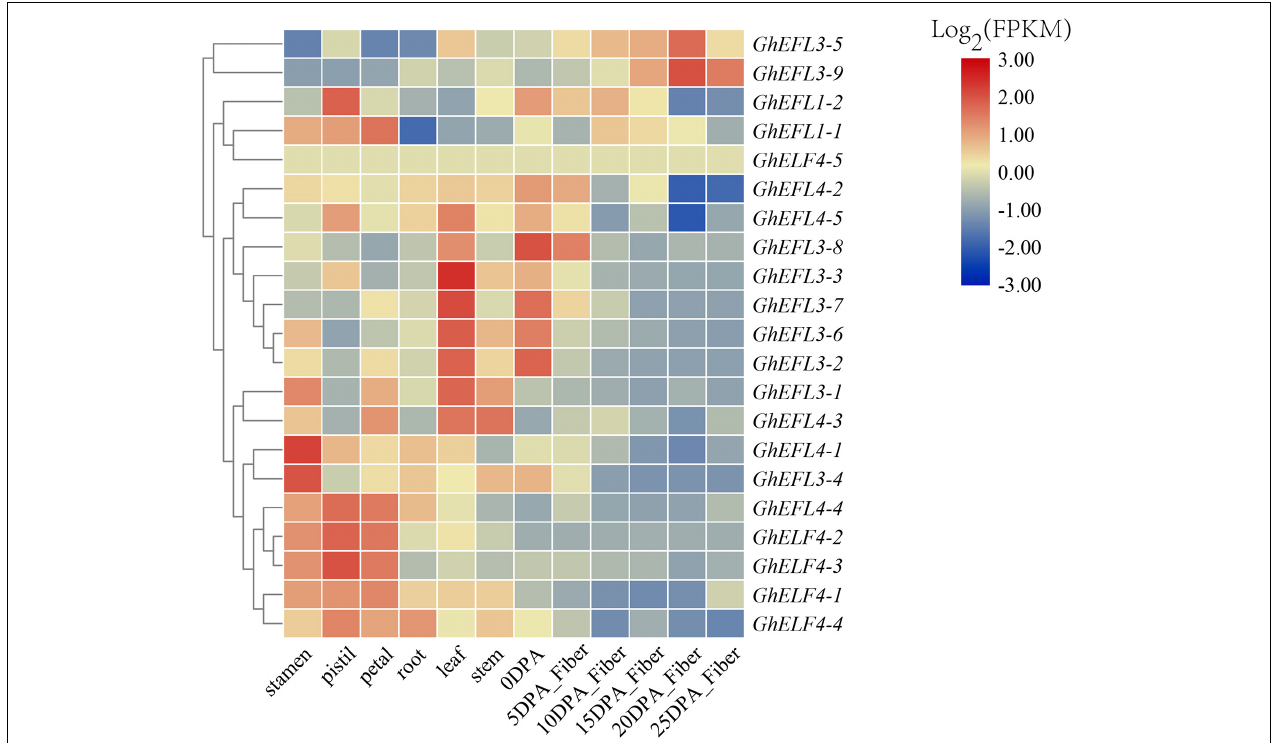
FIGURE 6 | Expression prediction of GhELF4s in different tissues. 0 to 25 DPA indicates 0, 5, 10, 15, 20, and 25 days after anthesis. The scale bars in the upper right corner represent log2-transformed FPKM